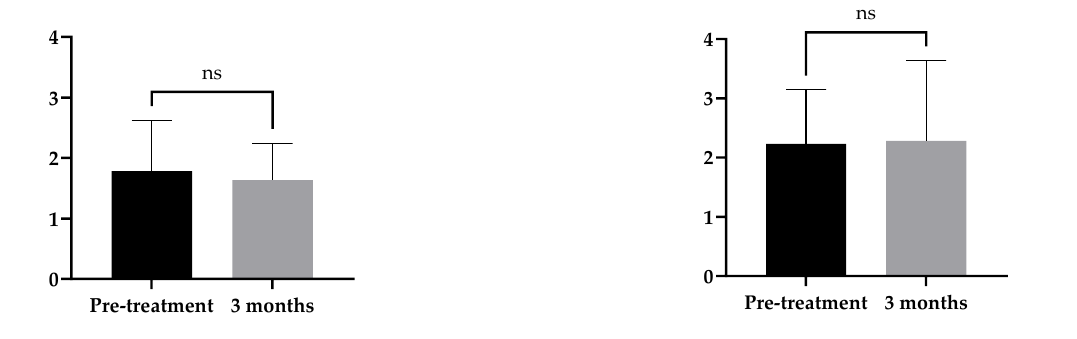
Figure 3. Change in neutrophil-to-lymphocyte ratio with a 3-month treatment with semaglutide or empagliflozin. Statistics: Wilcoxon matched-pairs signed rank-test; mean ± SD; ns p ≥ 0.05.